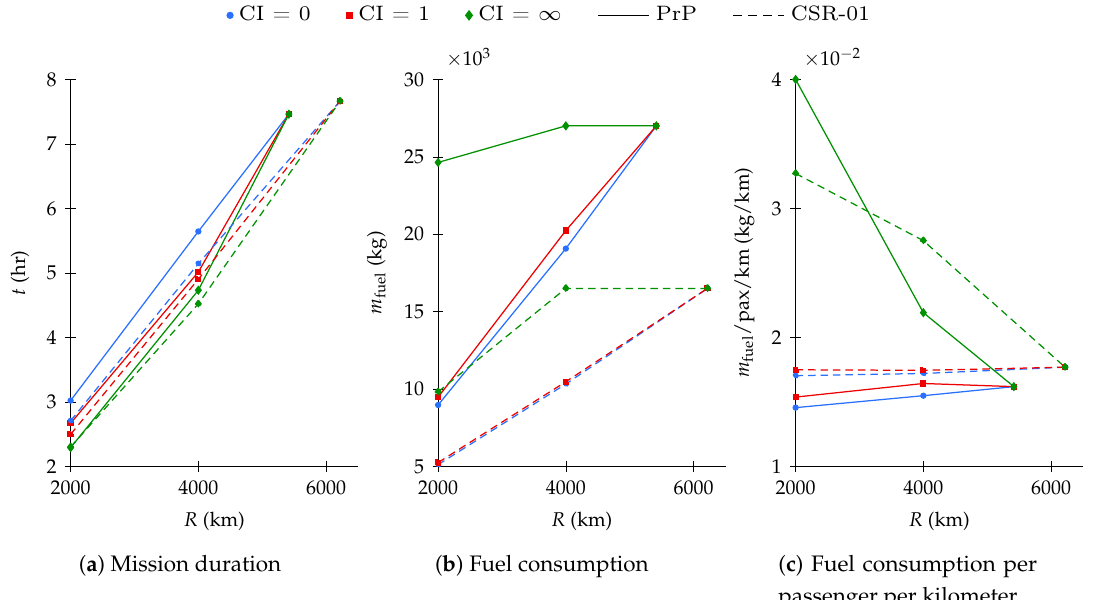
Figure 11. Top-level mission performance of the PrP and CSR-01 as a function of CI and